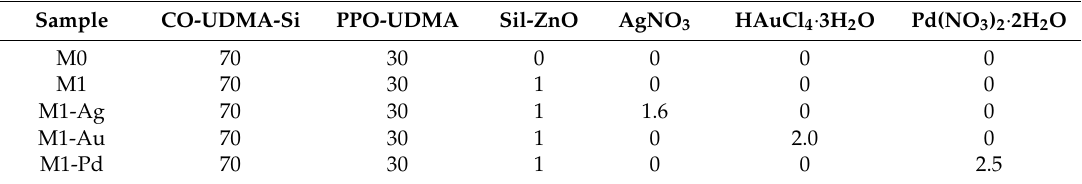
Table 1. Gravimetric composition of the investigated hybrid materials (each formulation contains 1 wt.% Irgacure